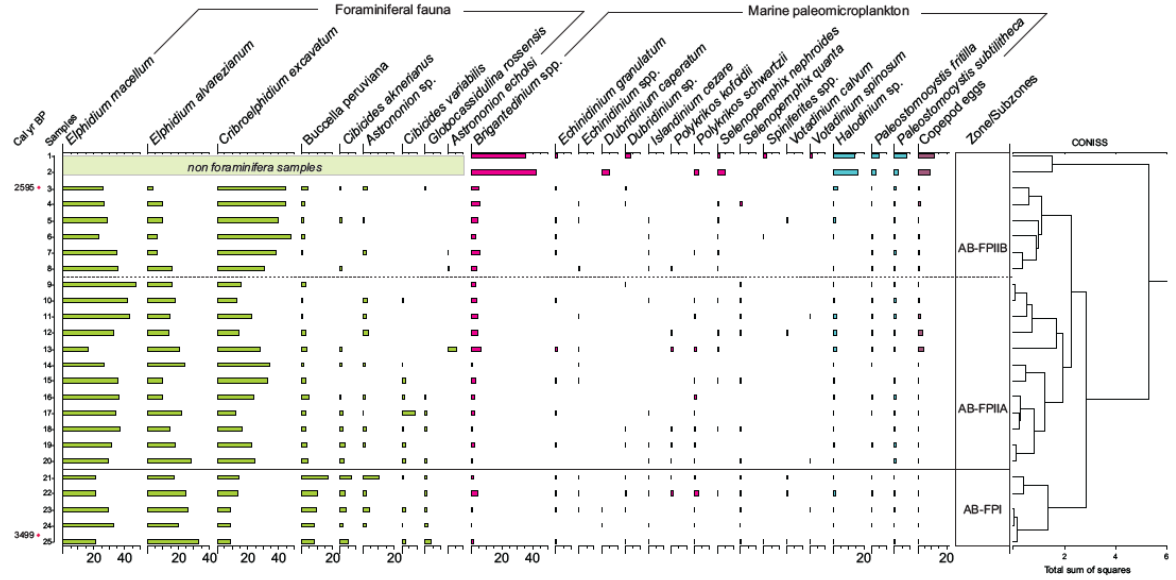
Figure 4. Summary of integrated analysis (main foraminifera species and marine microplankton data) from Arroyo Baliza